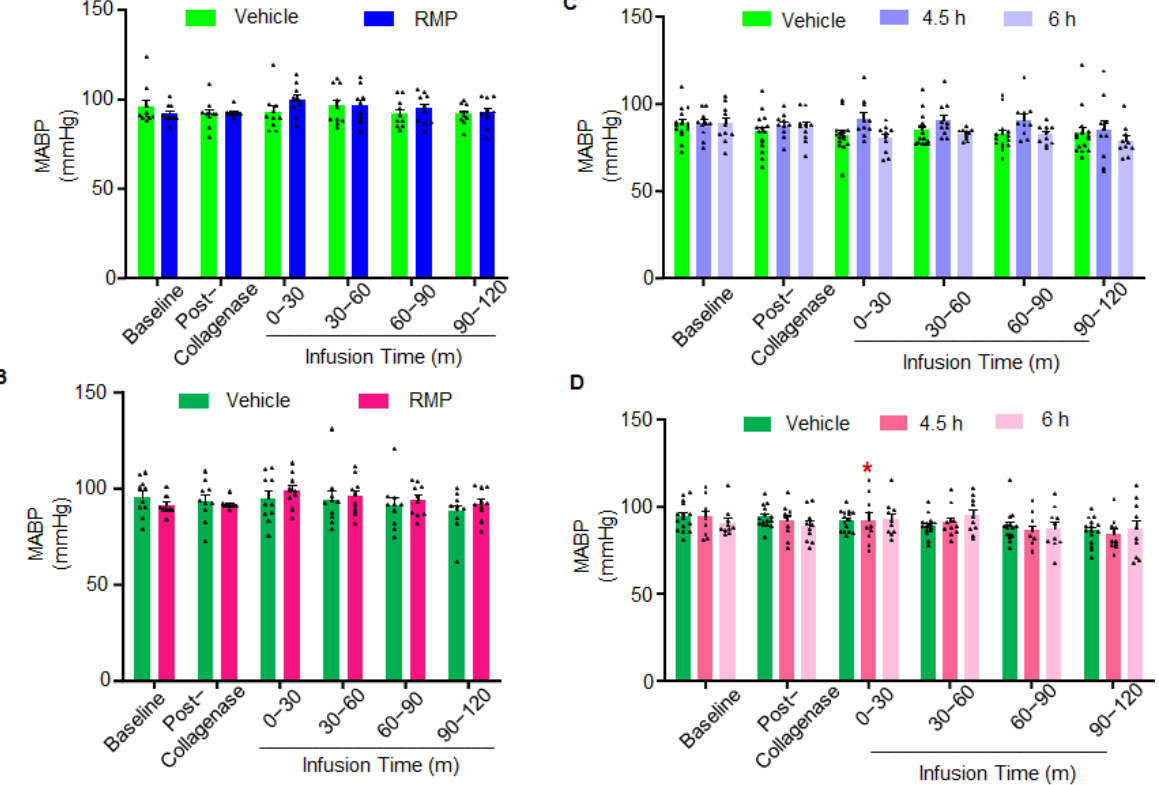
Figure 5. MABP data of groups of ( A ) male rats receiving vehicle or RMP; ( B ) female rats receiving vehicle or RMP; ( C ) male rats receiving vehicle or RMP 4.5 and 6 h post-sICH; and ( D ) female rats receiving vehicle or RMP 4.5 and 6 h post-sICH. * p < 0.05 vs. vehicle-treated rats.